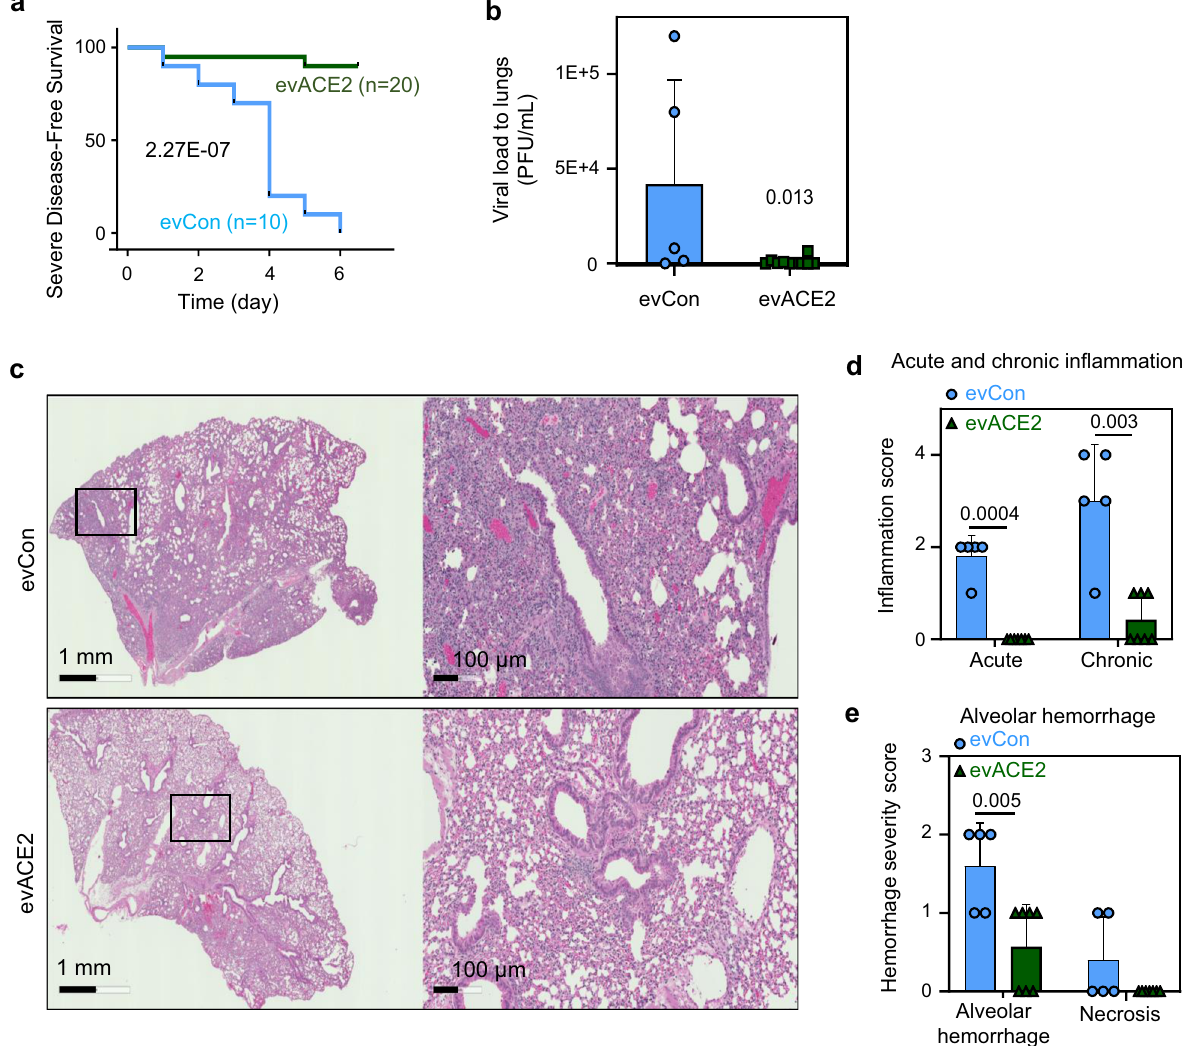
Fig. 4 evACE2 inhibits SARS-COV-2 infection and in fl ammation in hACE2 transgenic mice. a Probability of severe disease-free survival in